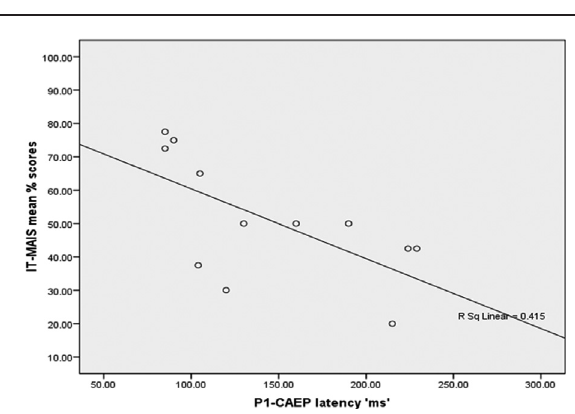
The higher mean Infant Toddler Meaningful Auditory Integration Scale (IT-MAIS) scores in the sensorineural hearing loss (SNHL) group compared with the auditory neuropathy spectrum disorder (ANSD) group across the two evaluation sessions.